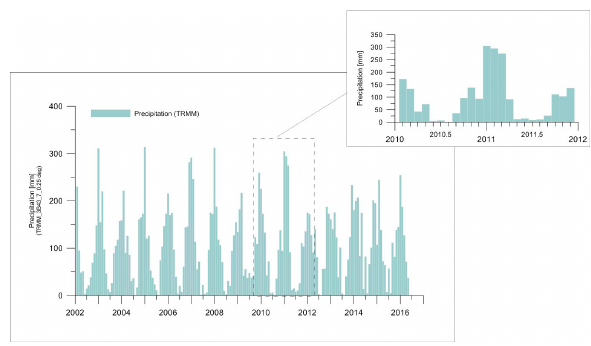
Fig. 5. Accumulated monthly precipitation in mm (TRMM) from 2002 to 2016 in the Pantanal area, and in the detail, the maximum and minimum rainfall in the period 2010-2012.